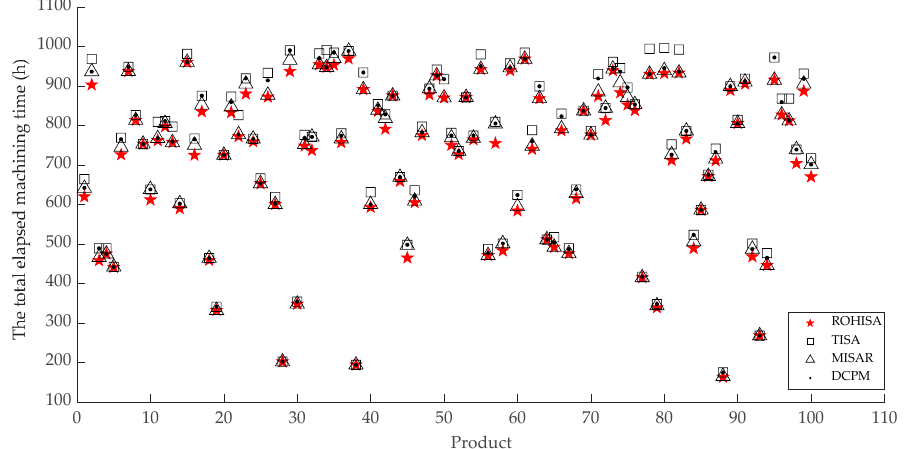
Figure 10. Comparison of the results of scheduling 100 trees by the TISA, DCPM, MISAR, and ROHISA.